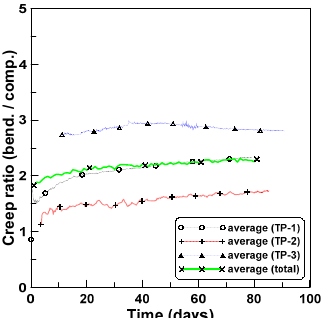
Figure 13. Ratios of tension creep to compression creep for TP-2 and TP-3 test series: ( a ) ratios for eight specimens of TP-2 and TP-3 and ( b ) average ratios of each test series. Figure 14. Ratios of bending creep to compression creep. Figure 14. Ratios of bending creep to compression